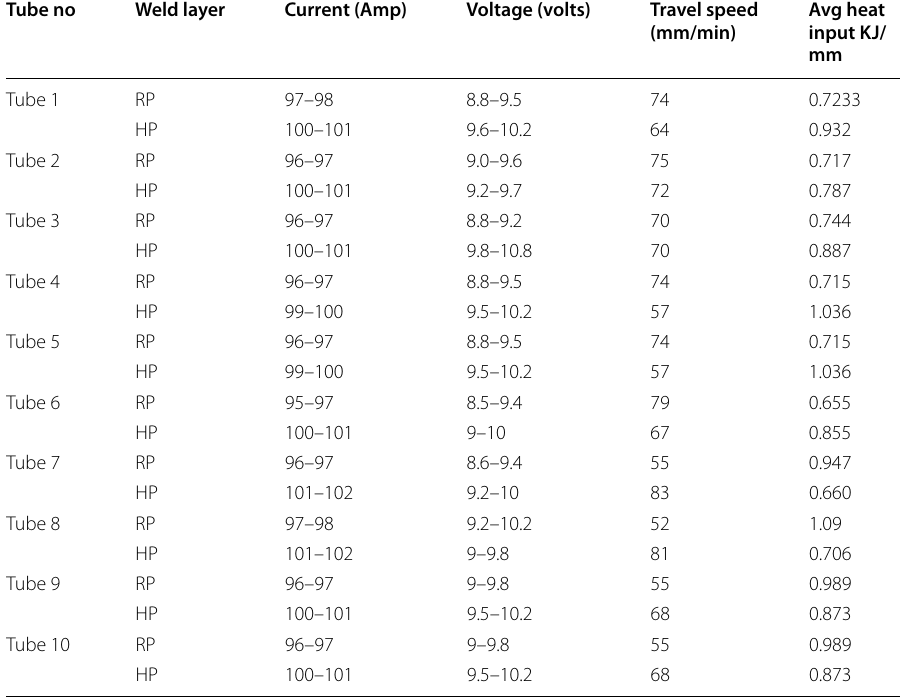
Table 3 Process parameters for P no.1 vs. P no.8 Tube no Weld